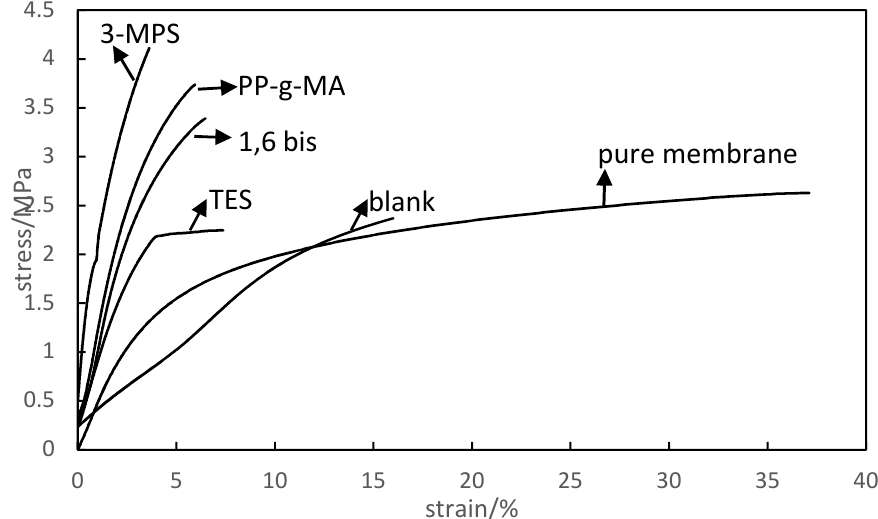
Figure 2. Stress–strain relationship of CEM composites with different modified GFs.